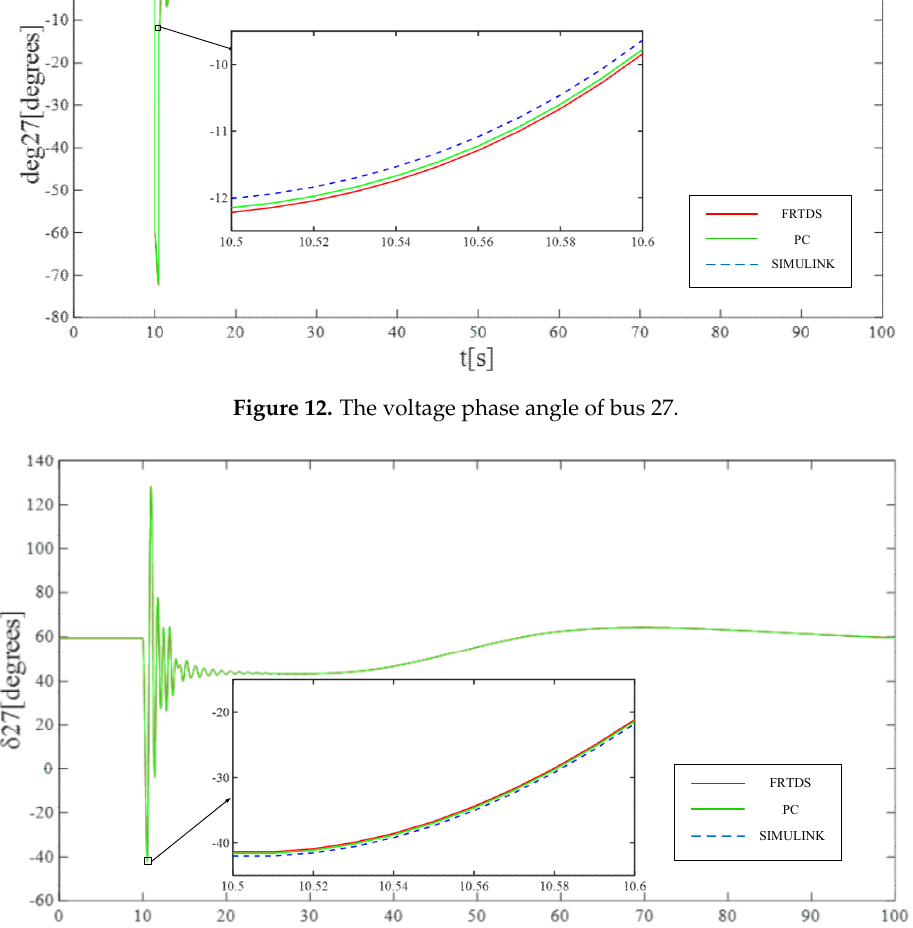
FRTDS SIMULINKPC Figure 14. The rotor angular velocity of the generator connected to bus 27. 6. Discussion The results of comparison showed that the computation time for a single time step in experiment 1 was far longer than that in experiments 2–5, which exceeded 10 ms. This indicated that the computation capability of FRTDS is beyond that of the PC, and the PC was not able to perform real- time simulation for the example system. The reason for this phenomenon is that the calculations are performed serially in a single core of CPU, whereas FPGA has considerable parallel computing capability and a deep pipeline mechanism that can perform parallel computation with multiple granularities. Thus, the parallelism of simulation was improved, and the simulation time was reduced. In FRTDS, the simulation could not be performed in experiments 2 and 3 because the computation time for a single time step exceeded 10 ms in both experiments. Real-time simulation was performed in experiments 4 and 5. Compared with experiment 4, the computation time in experiment 5 was shorter, which indicated that the computing capability of the hardware in experiment 4 was the best in experiments 2–5. The computation time decreased from experiment 2–